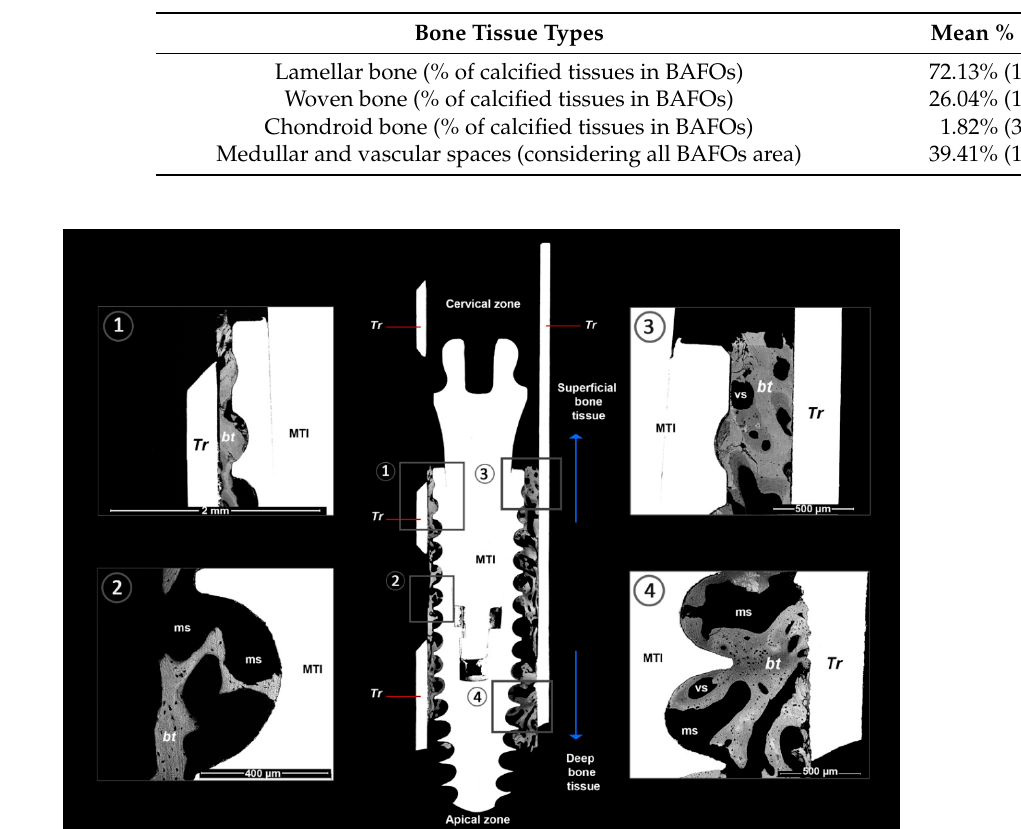
Table 2. Summary of quantitative analysis of samples considering bone tissue types. BAFOs with calcified tissues were considered (N = 243). SD = standard deviation.